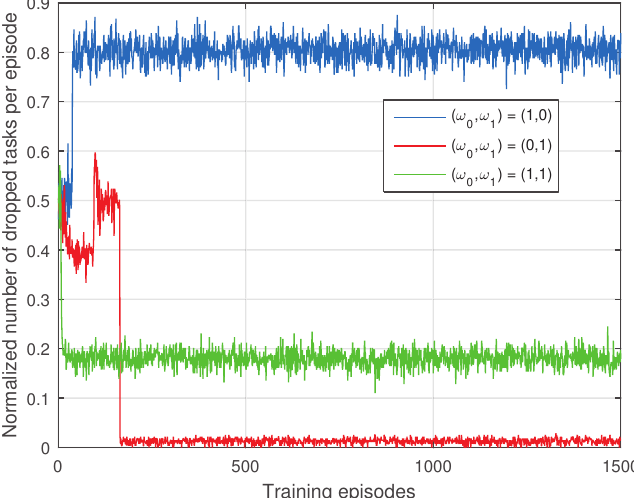
Figure 4. The impact of the weights on the normalized number of dropped tasks per episode.